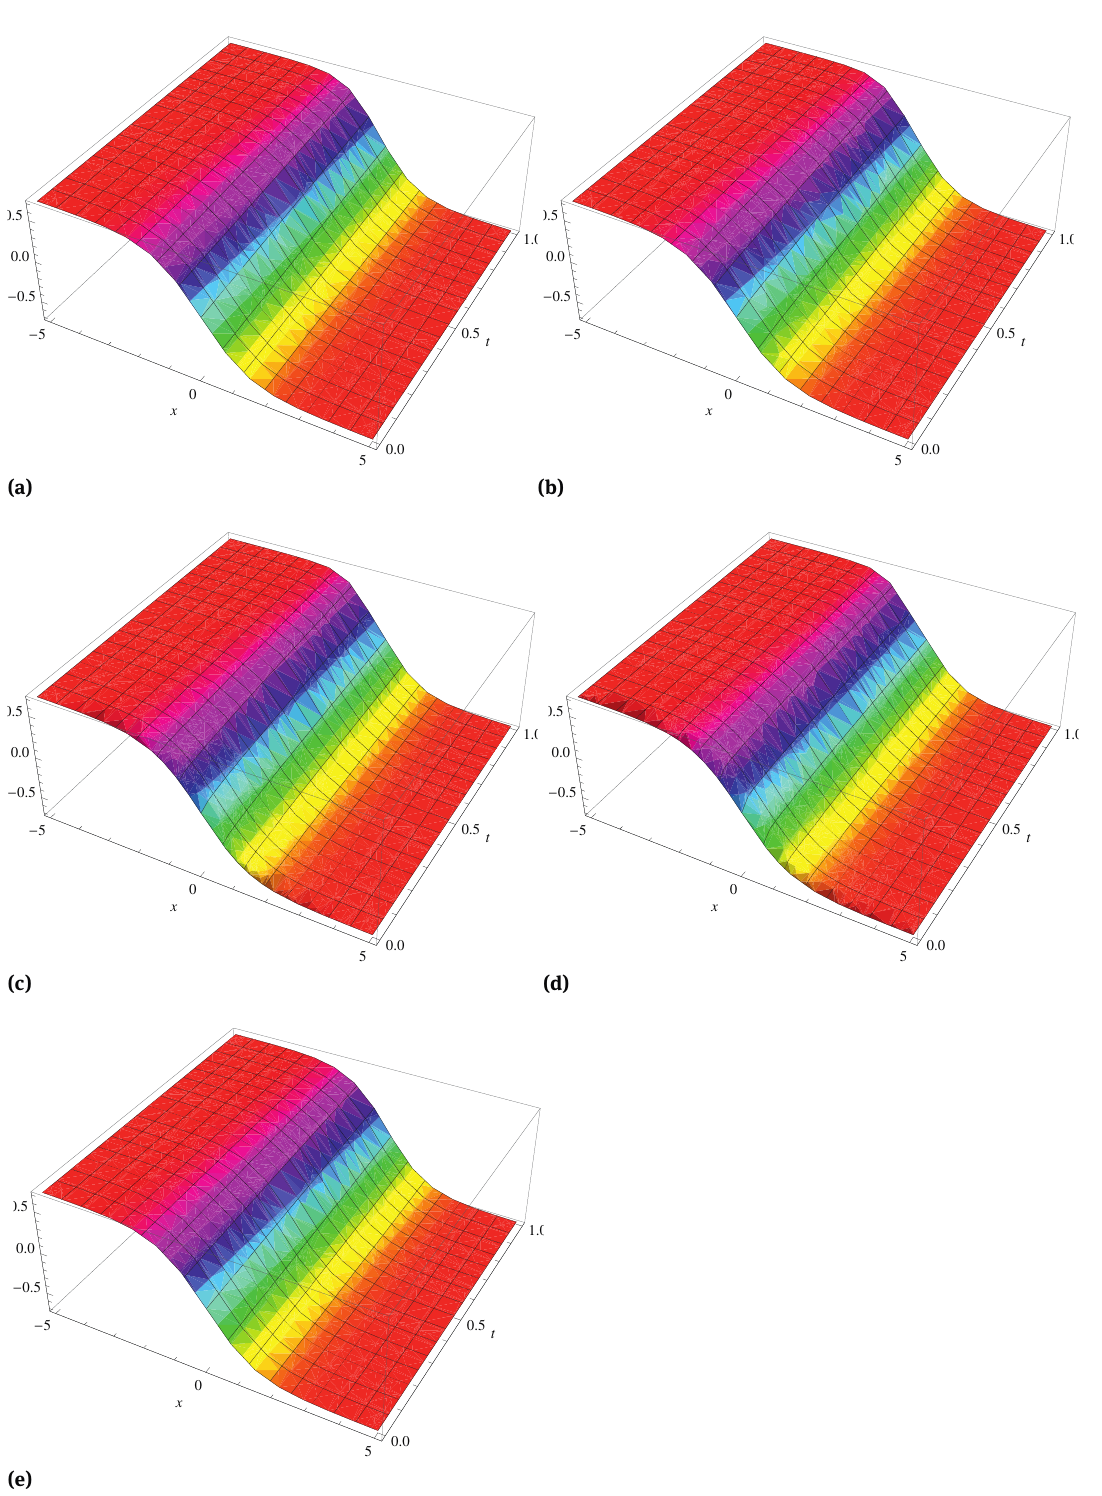
Fig. 1: The 4th order approximate solution of the Foam model: (a) u 4 ( x , t ) when α = 1 . (b) u 4 ( x , t ) when α = 0.75 . (c) u 4 ( x , t ) when α = 0.5 . (d) u 4 ( x , t ) when α = 0.25 . (e) Exact solution u ( x , t ) when α = 1